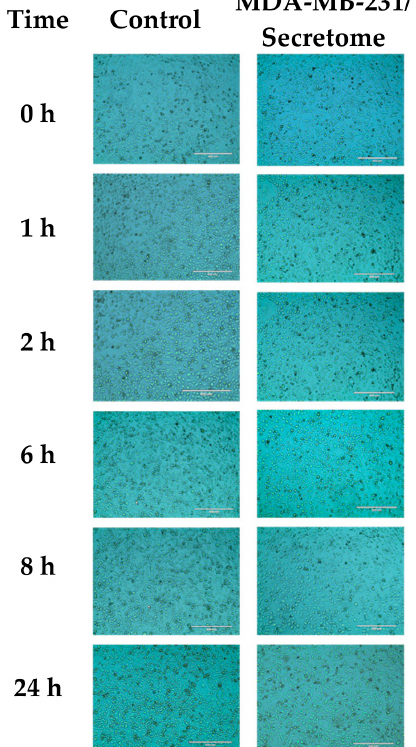
Figure 1. Morphological changes in MDA-MB-231 cells treated with 10% E. coli secretome at dif- ferent time points (0, 1, 2, 6, 8, and 24 h). Magnification: 10×. time points (0, 1, 2, 6, 8, and 24 h). Magnification: 10